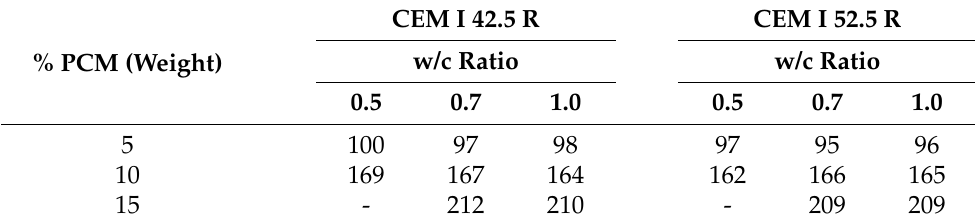
Table 9. PCM content in the studied samples (expressed as kg/m 3 of